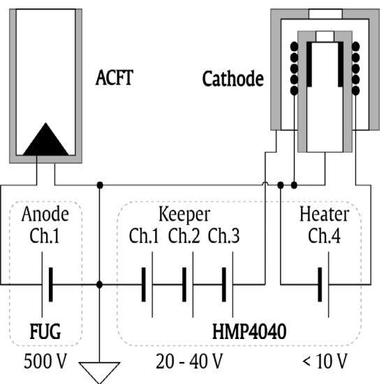
Endurance test setup within the 40-l vacuum chamber. The Alberich ACFT is displayed on the right, while the hollow cathode MK 2.1 is on the left.